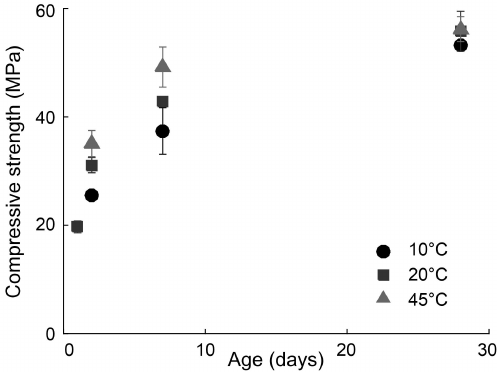
Figure 10. Influence of curing temperature on compressive strength.